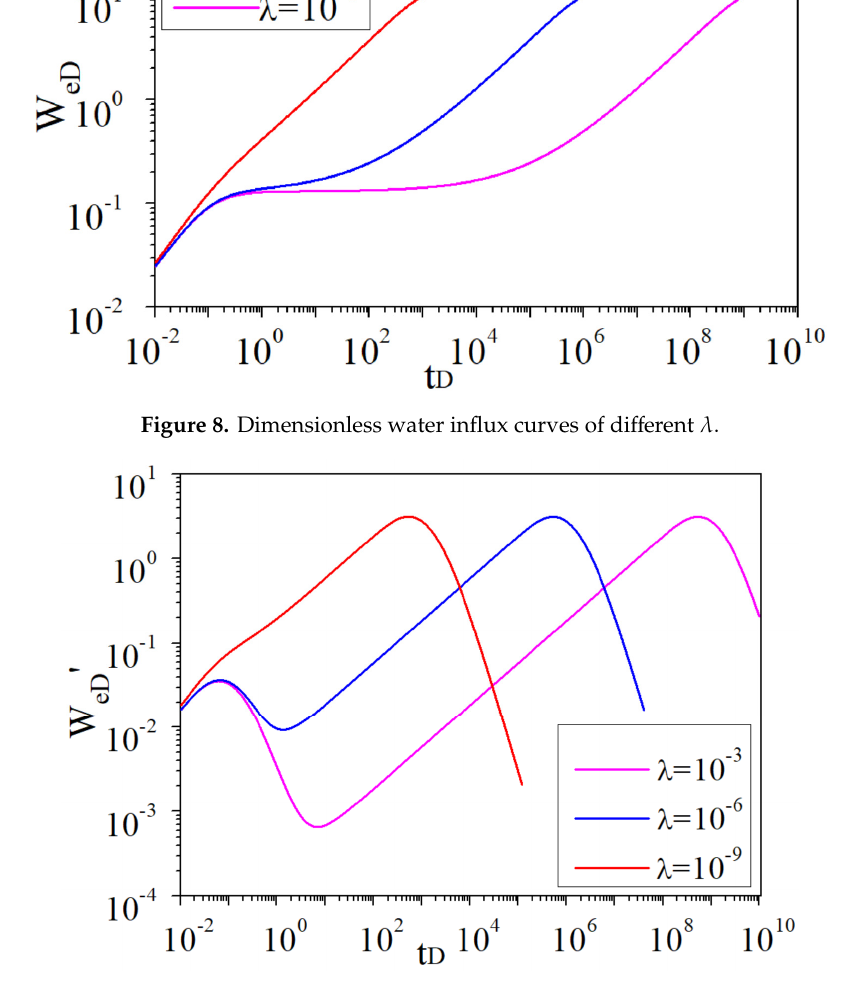
ff erent λ λ . Figure 9. Dimensionless water influx derivative curves of di λ .